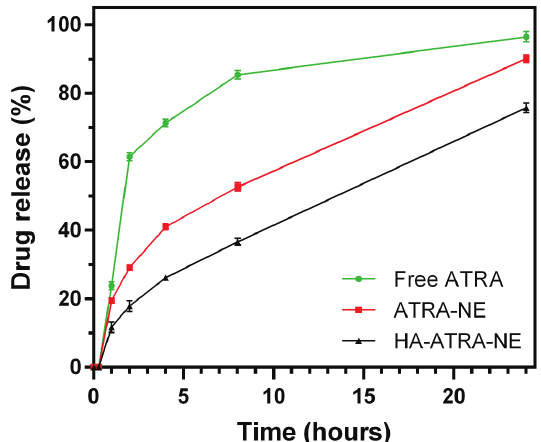
FIGURE 5 – Cumulative ATRA release from NE compared to a solution at 37 ± 0.5